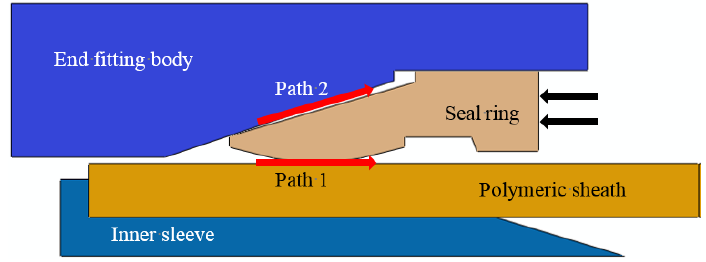
Figure 2. Schematic illustration of the sealing structure.